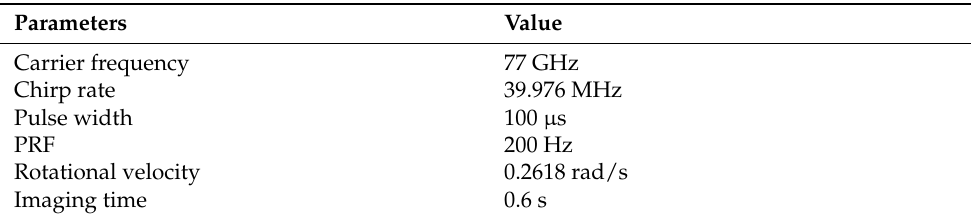
Table 4. Parameters of the experiment system.